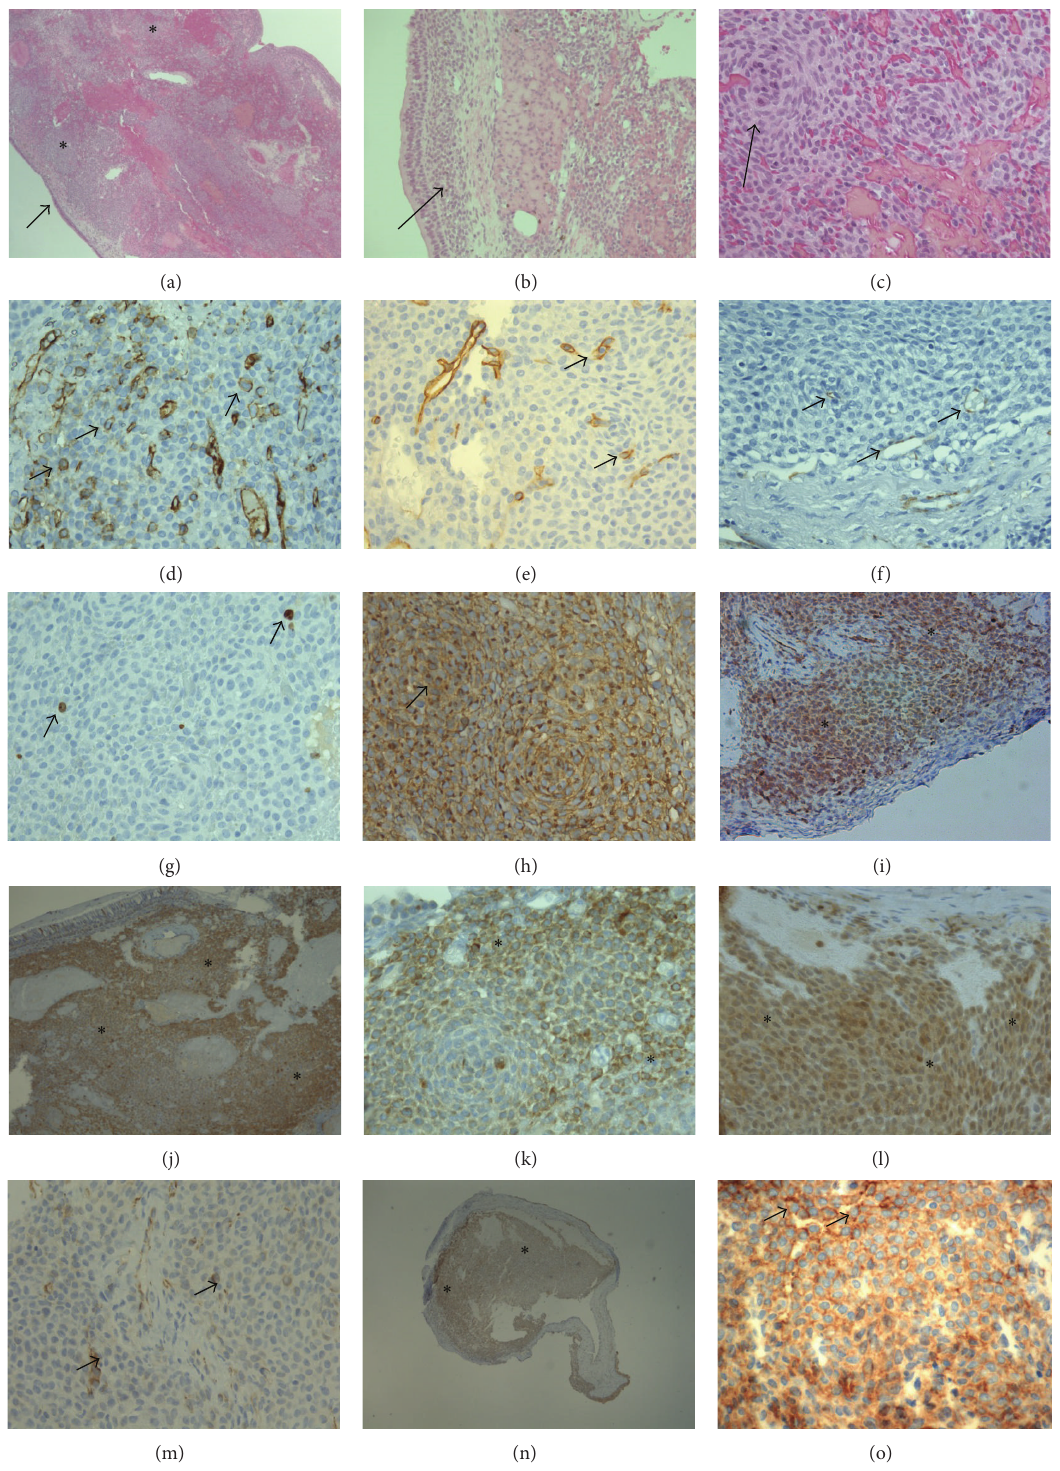
Figure 1: (a)–(c) Histopathological section of the biopsy showing the tumor as located in the nasal mucosa ((a) asterisks for the tumor tissue, arrow for mucosa). (b) Focal collection of submucosal tumor cells (arrow). (c) Occasional whirling pattern of tumor cells (arrow). ((a)–(c) Hematoxylin and eosin stain.) (d)–(n) Tumor cells expressing CD31 (d) and CD34 (e), showing missing expression of D2-40 ((f) arrows for rare intratumor positive vessels), expressing nuclear Ki67 ((g) arrows), CD99 ((h) dot-like cytoplasmic expression in some tumor cells/arrow), CD146 ((i) asterisks for positive tumor cells), and Bcl2 ((j)-(k) asterisks in the positive zones, some of them at the periphery of negative whirling zones), as well as progesterone receptor ((l) asterisks), WT1 ((m) arrows), and expressing moderately and diffusely mTOR ((n) asterisks) and membrane and cytoplasmic EGFR ((o) arrows). Magnification × 25 ((a), (n)), × 50 ((b), (j)), × 200 (i), and × 400 ((c), (d), (e), (f), (g), (h), (k), (l), (m),